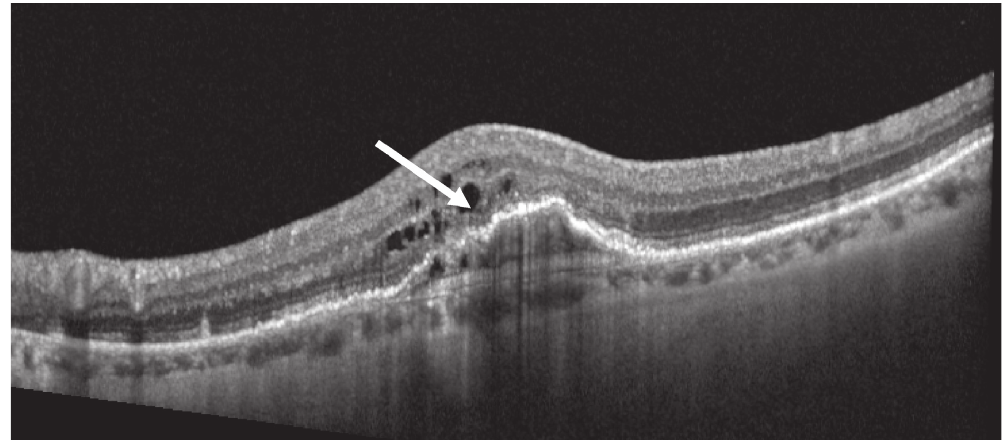
Figure 2: Structural OCT biomarkers: photoreceptors layer degeneration (white arrow).